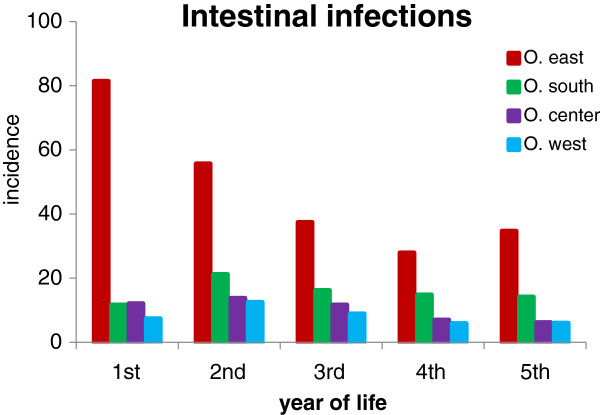
Incidence of intestinal infectious diseases per 100 children per year of life. Numbers of children stratified by age and region of residence are presented in Table 3.